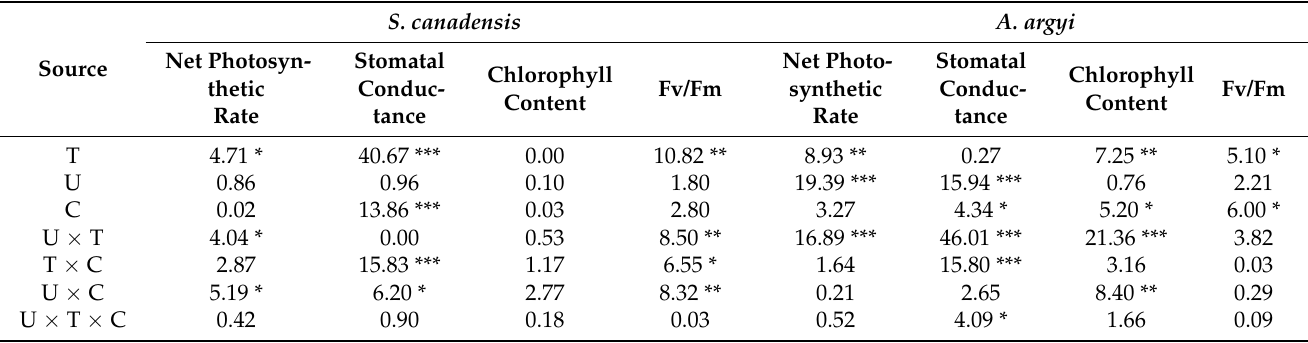
Table 2. Mixed effects analysis of temperature (T), UV light (U), and plant community on photosyn- thetic traits of invasive Solidago canadensis and native Artemisia argyi when grown in monoculture and together in a mixed